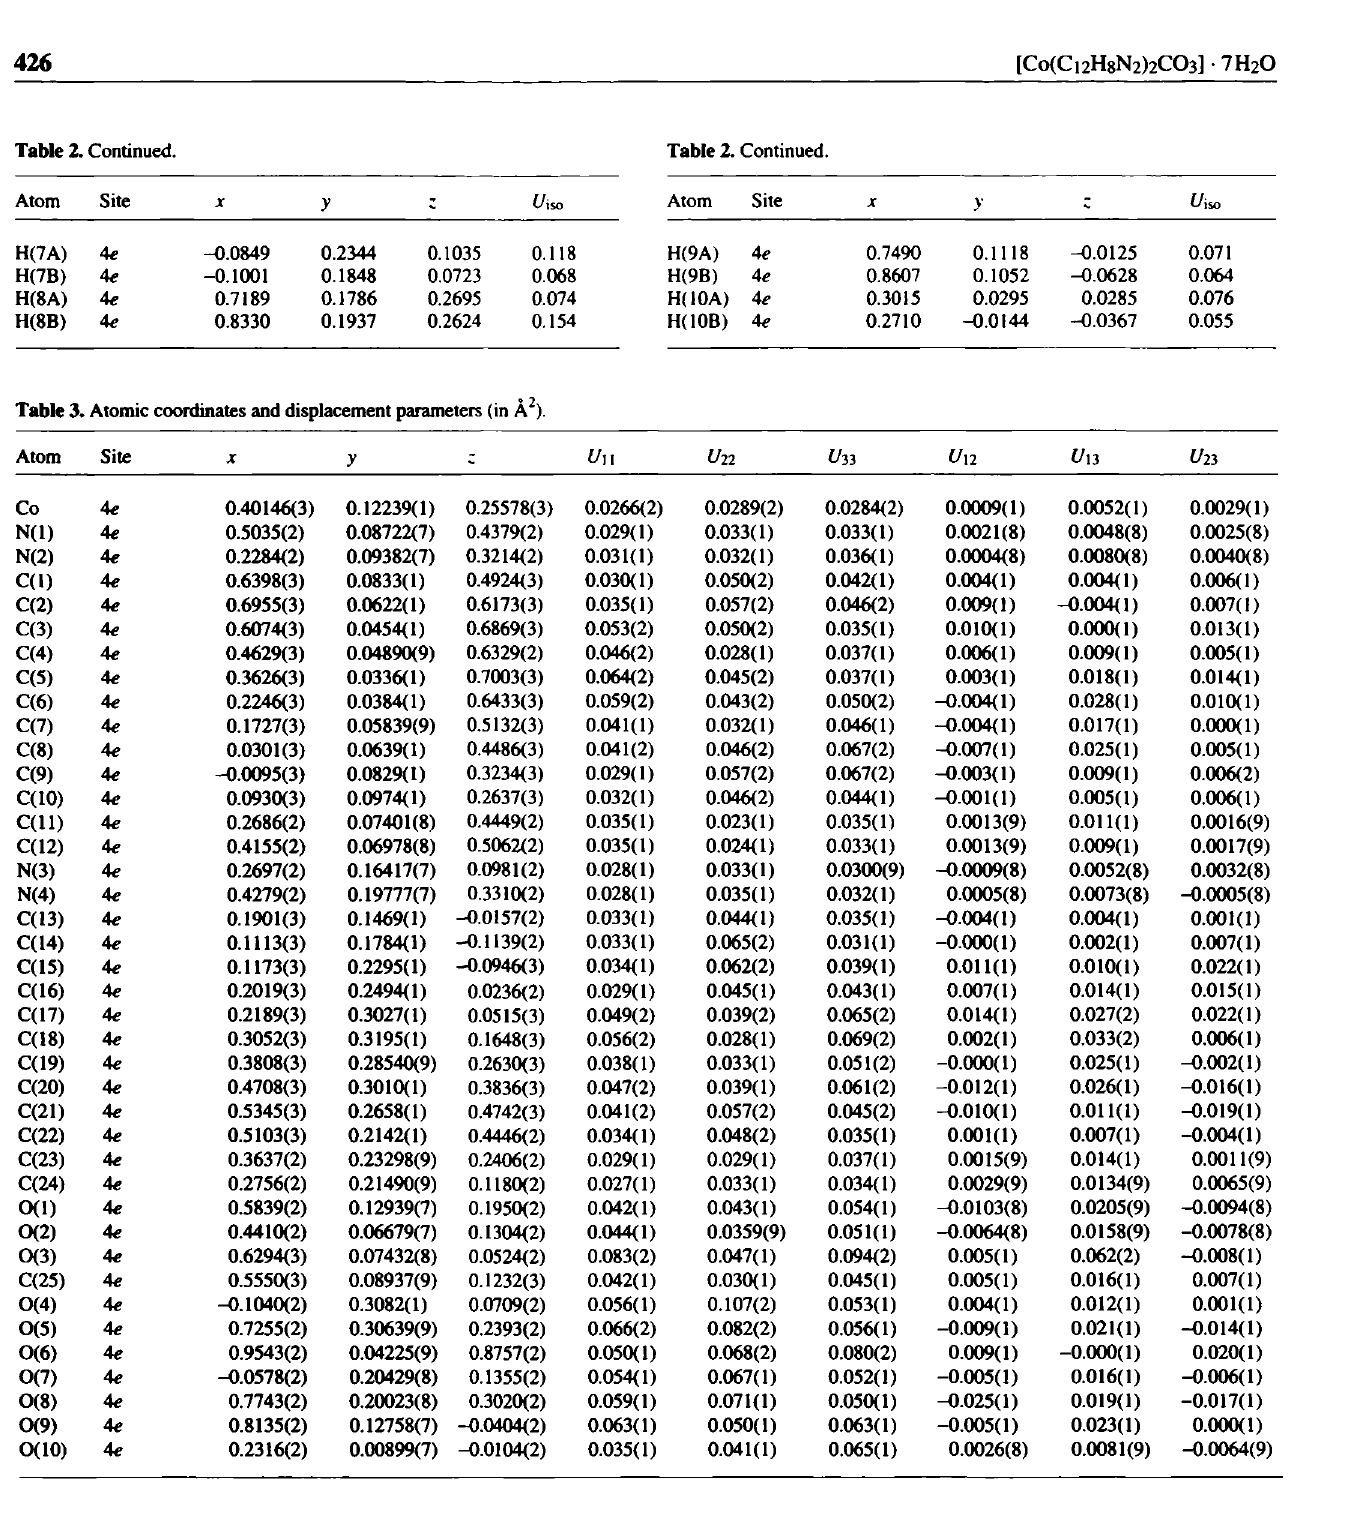
Table 3. Atomic coordinates and displacement parameters (in A 2